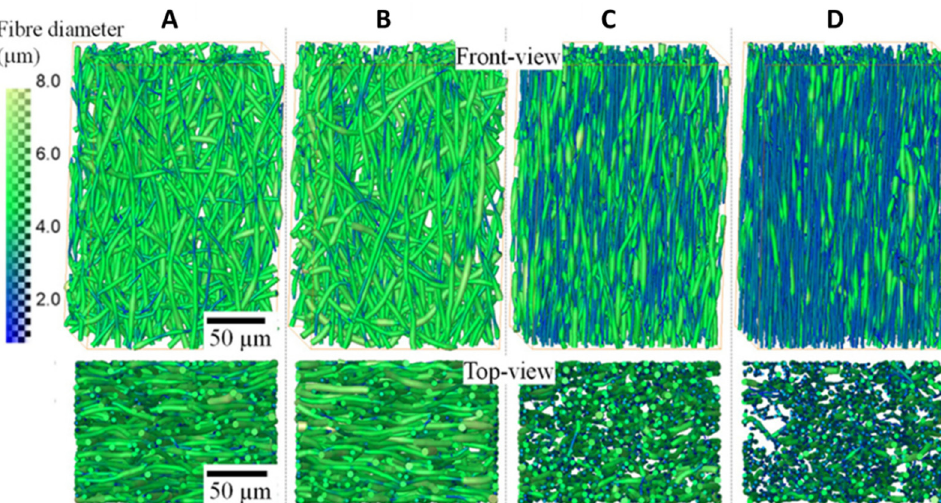
Figure 5. Front and top view 3D rendering of small volumes of the P(3HB-co-4HB) fiber mats and fiber diameter distributions for the unstrained ( A ), 33% ( B ), 193% ( C ), and 352% strained ( D ). The color map on the left represents fiber diameter in micrometers, reproduced after [166] (published under Creative Commons Attribution